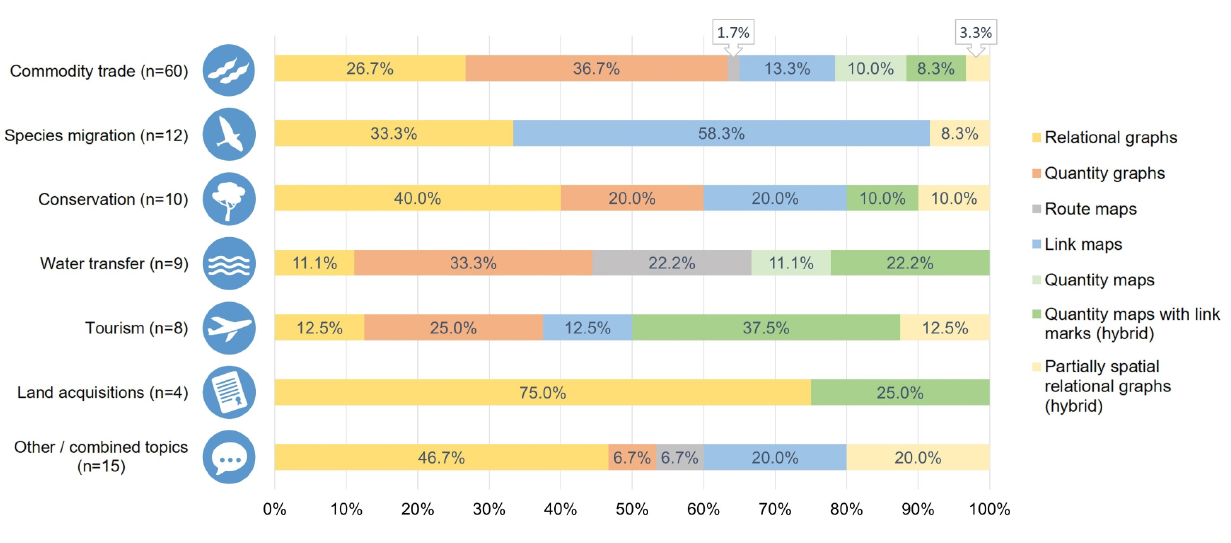
Fig. 9 . Relative frequency of use of visualization types for each telecoupling